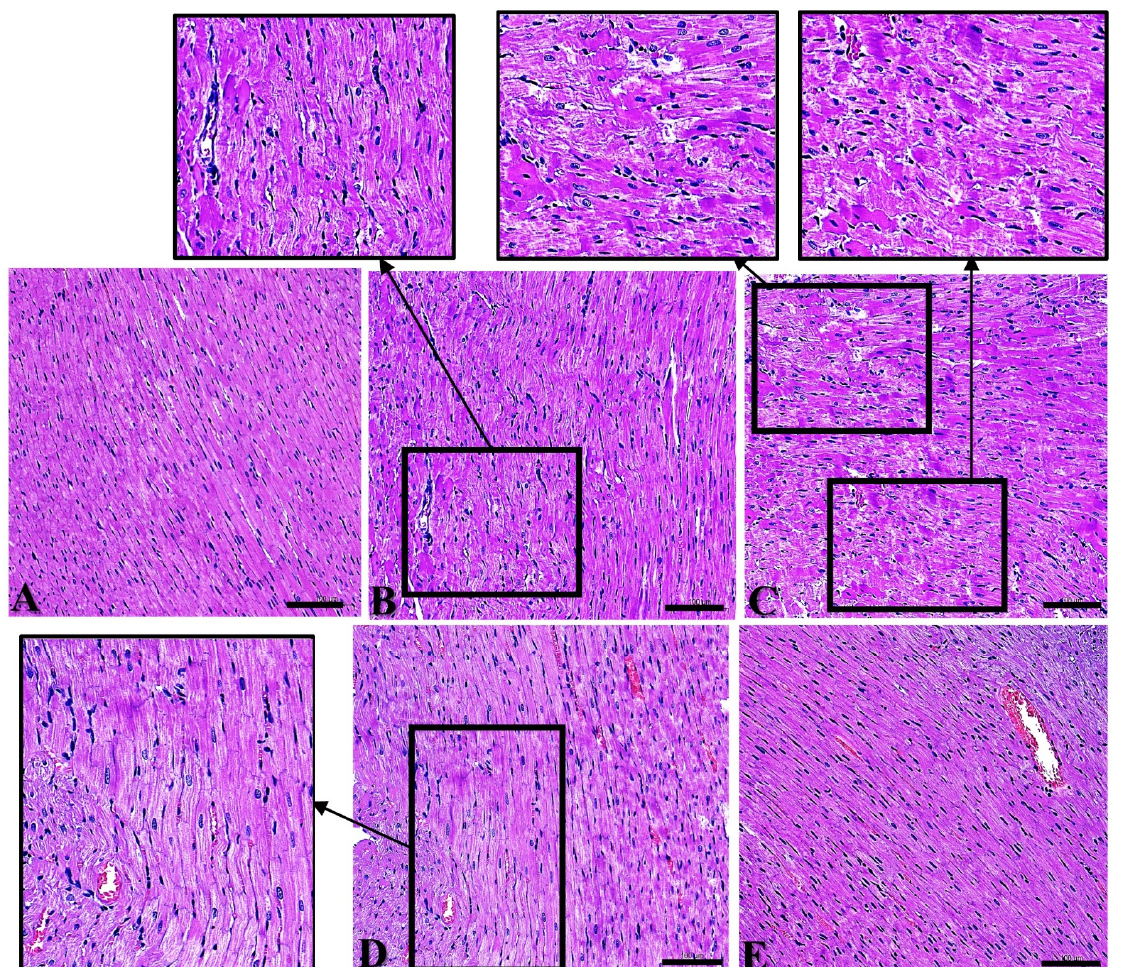
Figure 1. Structural changes to rat’s myocardium after S-band exposure. ( A ) Group C; ( B ) Group R on Day 1; ( C ) Group R on Day 7; ( D ) Group R on Day 14; ( E ) Group R on Day 28. ( A – E ) ×400, scale bar = 100 µm (black frames indicate wavy myocardial fi bers and damaged areas).